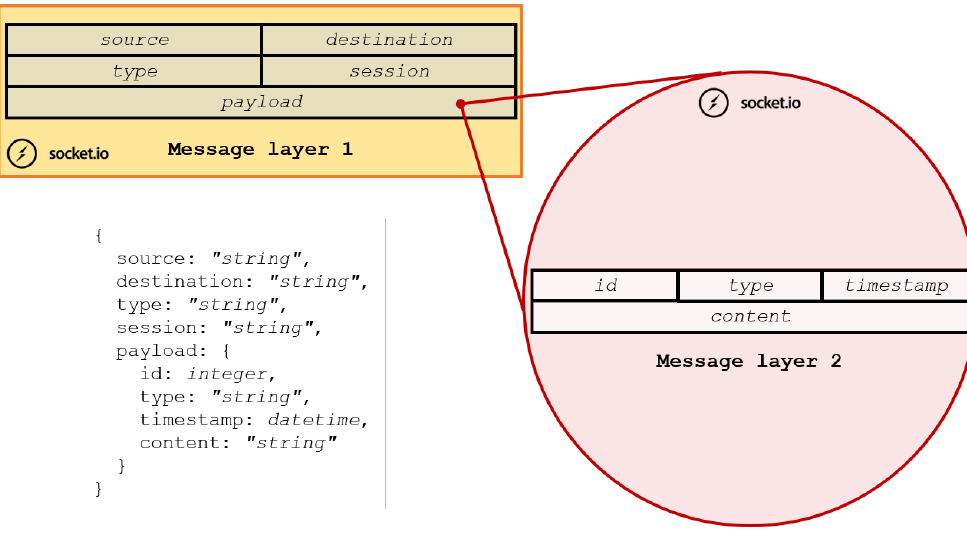
Figure 5. RedHerd message prototype.